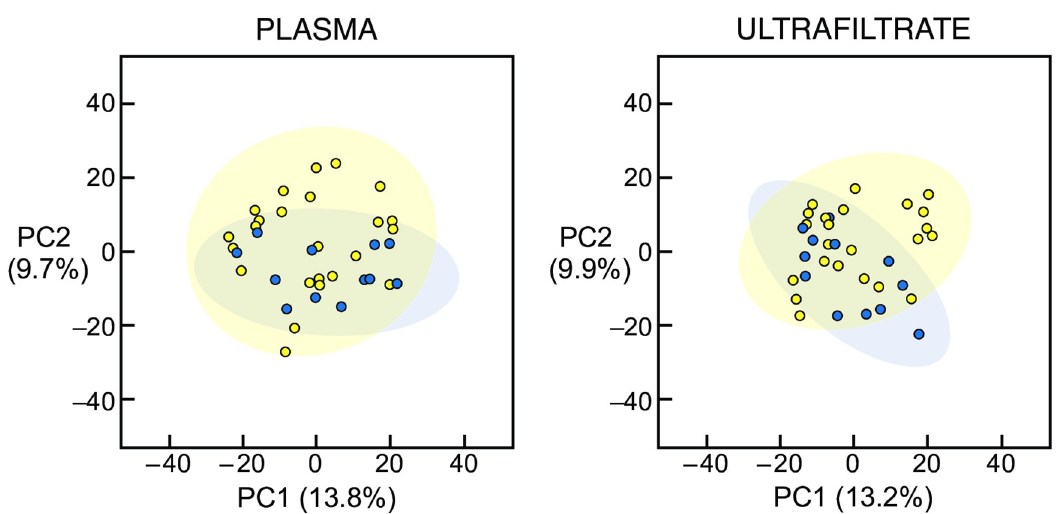
Fig 2. Principal component analysis of uremic solutes in plasma and ultrafiltrate of hemodialysis patients. Principal component analysis score plots of the uremic solute profile in the plasma (left panel) and ultrafiltrate (right panel) are illustrated. There was no difference in the uremic solute profile between the 12 Itch patients (blue circles) and the 24 No Itch patients (yellow circles). PC1, principal component 1; PC2, principal component 2.